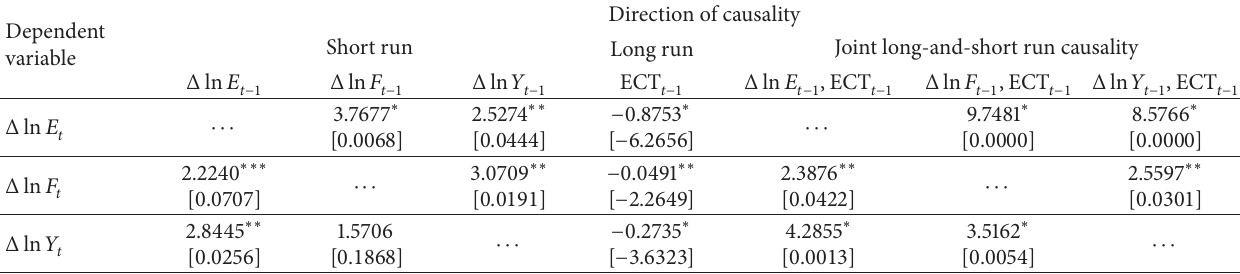
Table 8: VECM Granger causality